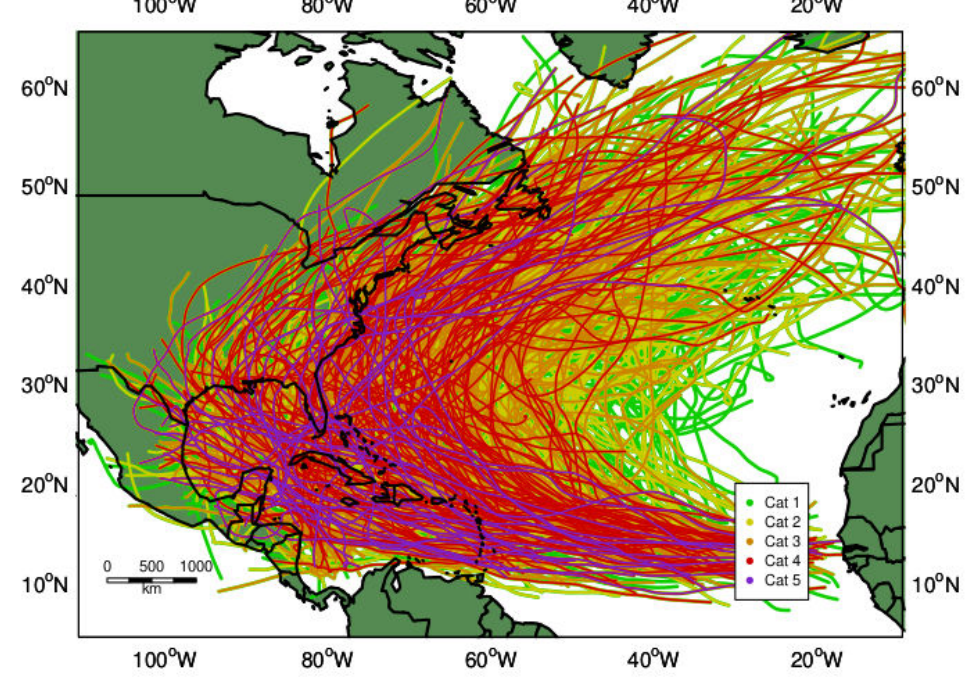
Figure 1. North Atlantic Hurricane Tracks from 1854–2018. Hurricanes are color coded by Saffir–Simpson Category at maximum sustained wind intensity. Category 1, 33–42 ms − 1 ,